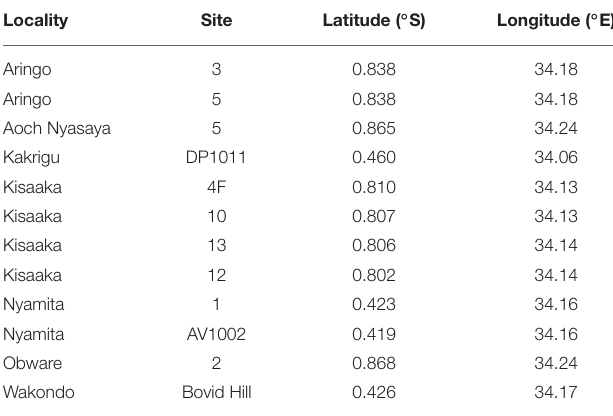
TABLE 1 | GPS coordinates of paleosols used in this